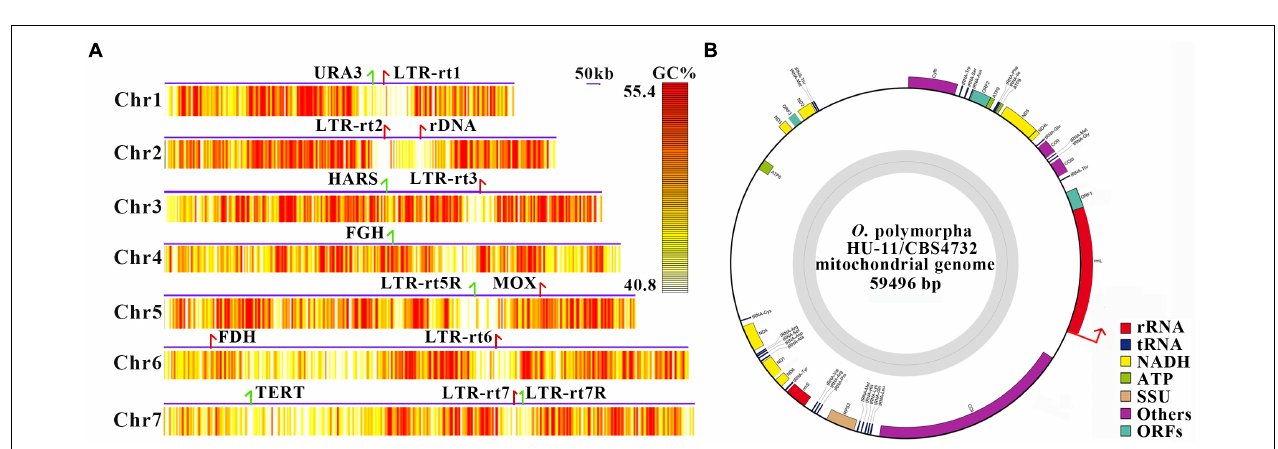
FIGURE 2 | Full-length genome of Ogataea polymorpha HU-11/CBS4732. (A) The full-length O. polymorpha HU-11/CBS4732 genome includes the complete sequences of seven linear chromosomes, which were named as 1–7 from the smallest to the largest. The 5 (cid:48) and 3 (cid:48) telomeric regions were not included. The minimum, Q 90 , Q 75 , Q 50 , Q 25 , Q 10 , and maximum of GC contents (%) are 0.08, 0.408 0.436, 0.472, 0.514, 0.554, and 0.732. The GC contents (%) were calculated by 500-bp sliding windows and then trimmed between Q 10 and Q 90 for plotting the heatmaps. Long terminal repeat retrotransposons (LTR-rts) and markers genes are indicated by arrows (red and green colors represent sense and antisense strands) in the chromosomes. Markers genes of chromosome 1–7 include URA3 (encoding orotidine 5 (cid:48) -phosphate decarboxylase), rDNA, HARS (Hansenula autonomously replicating sequence), FGH (S-formylglutathione hydrolase), MOX (methanol oxidase), FDH (Formate dehydrogenase) and TERT (telomerase reverse transcriptase), respectively. (B) For the data submission to the GenBank database, the genome sequence of circular mitochondrion was anticlockwise linearized, starting at the first nt (indicated by a red arrow) of rrnL, which may include a part of the control region. SSU, small subunit; RPS3, ribosomal protein S3; rrnL, large subunit ribosomal RNA; rrnS, small subunit ribosomal RNA.